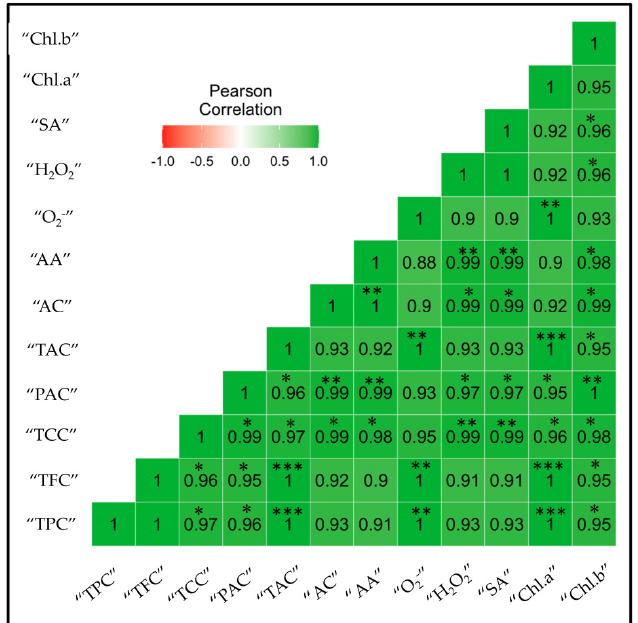
Figure 7. Correlational matrix of secondary metabolic compounds in poplar 717 leaves under drought stress. The colored gradient legends represent coefficients of correlation r-values from +1.0 (dark green) to − 1.0 (dark red). Significant effects are indicated in boldface as follows: *** p ≤ 0.001, ** p ≤ 0.01, and * p ≤ 0.05. All coefficients were computed by the Pearson correlation for possible pairs of variables in the matrix.